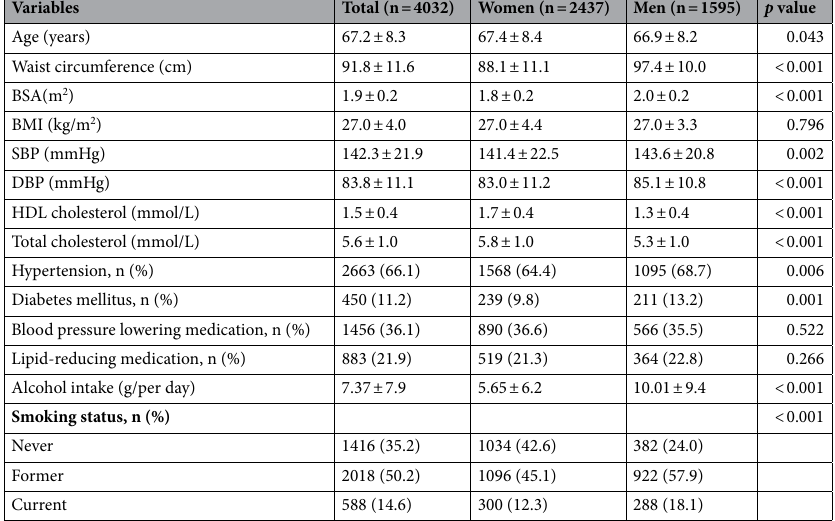
Table 1. Characteristics of study population. Values are presented as mean ± SD for continuous variables and numbers (percentages) for categorical variables. P-value refers to differences in baseline characteristics between women and men. BSA body surface area, BMI body mass index, SBP systolic blood pressure, DBP diastolic blood pressure, HDL high-density lipoprotein.